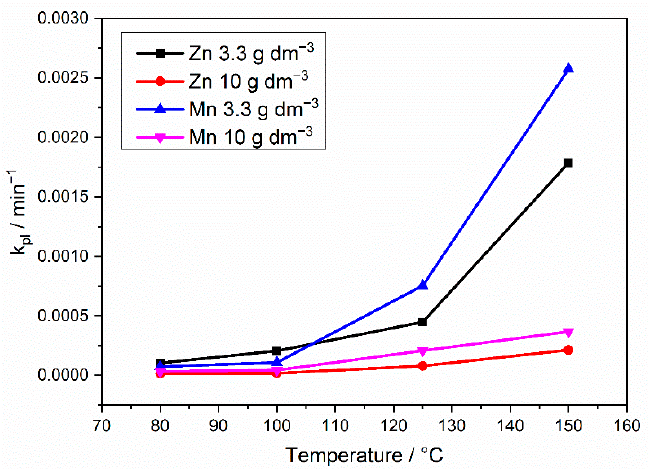
Figure 3. k pl as function of temperature for the leaching of Zn and Mn oxides and solid/NADES ratio.